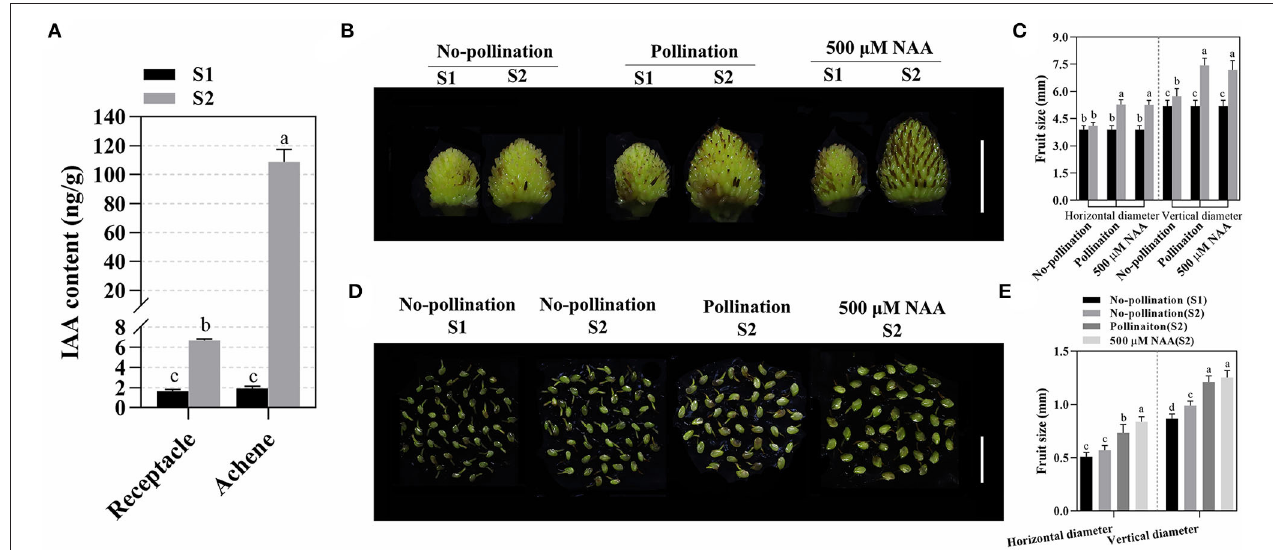
FIGURE 1 | Auxin accumulated in fruits and promoted fruit development. (A) IAA was highly accumulated in receptacles and achenes during fruit set. Data are represented as means ± SD ( n = 3, one-way ANOVA). About 15–20 fruits were used for each replicate, and the achenes and receptacles were sampled separately. S1 and S2 indicate stage 1 and stage 2, respectively. Statistical analysis shows the significant difference between the groups ( p < 0.05, one-way ANOVA). (B) Fruit development after pollination or auxin treatment. Scale bar = 0.5cm. (C) Quantification of vertical and horizontal diameters for fruits after pollination or auxin treatment. Error bar represents SD, n = 15–20. Statistical analysis showed the significant difference between the groups ( p < 0.05, one-way ANOVA). (D) Achene growth after pollination or auxin treatments. Scale bar = 0.5cm. (E) Quantification of achene size in different conditions. Error bars represent SD, n = 60 achenes from 15 to 20 fruits. Statistical analysis indicated the significant difference between the groups ( p < 0.05, one-way